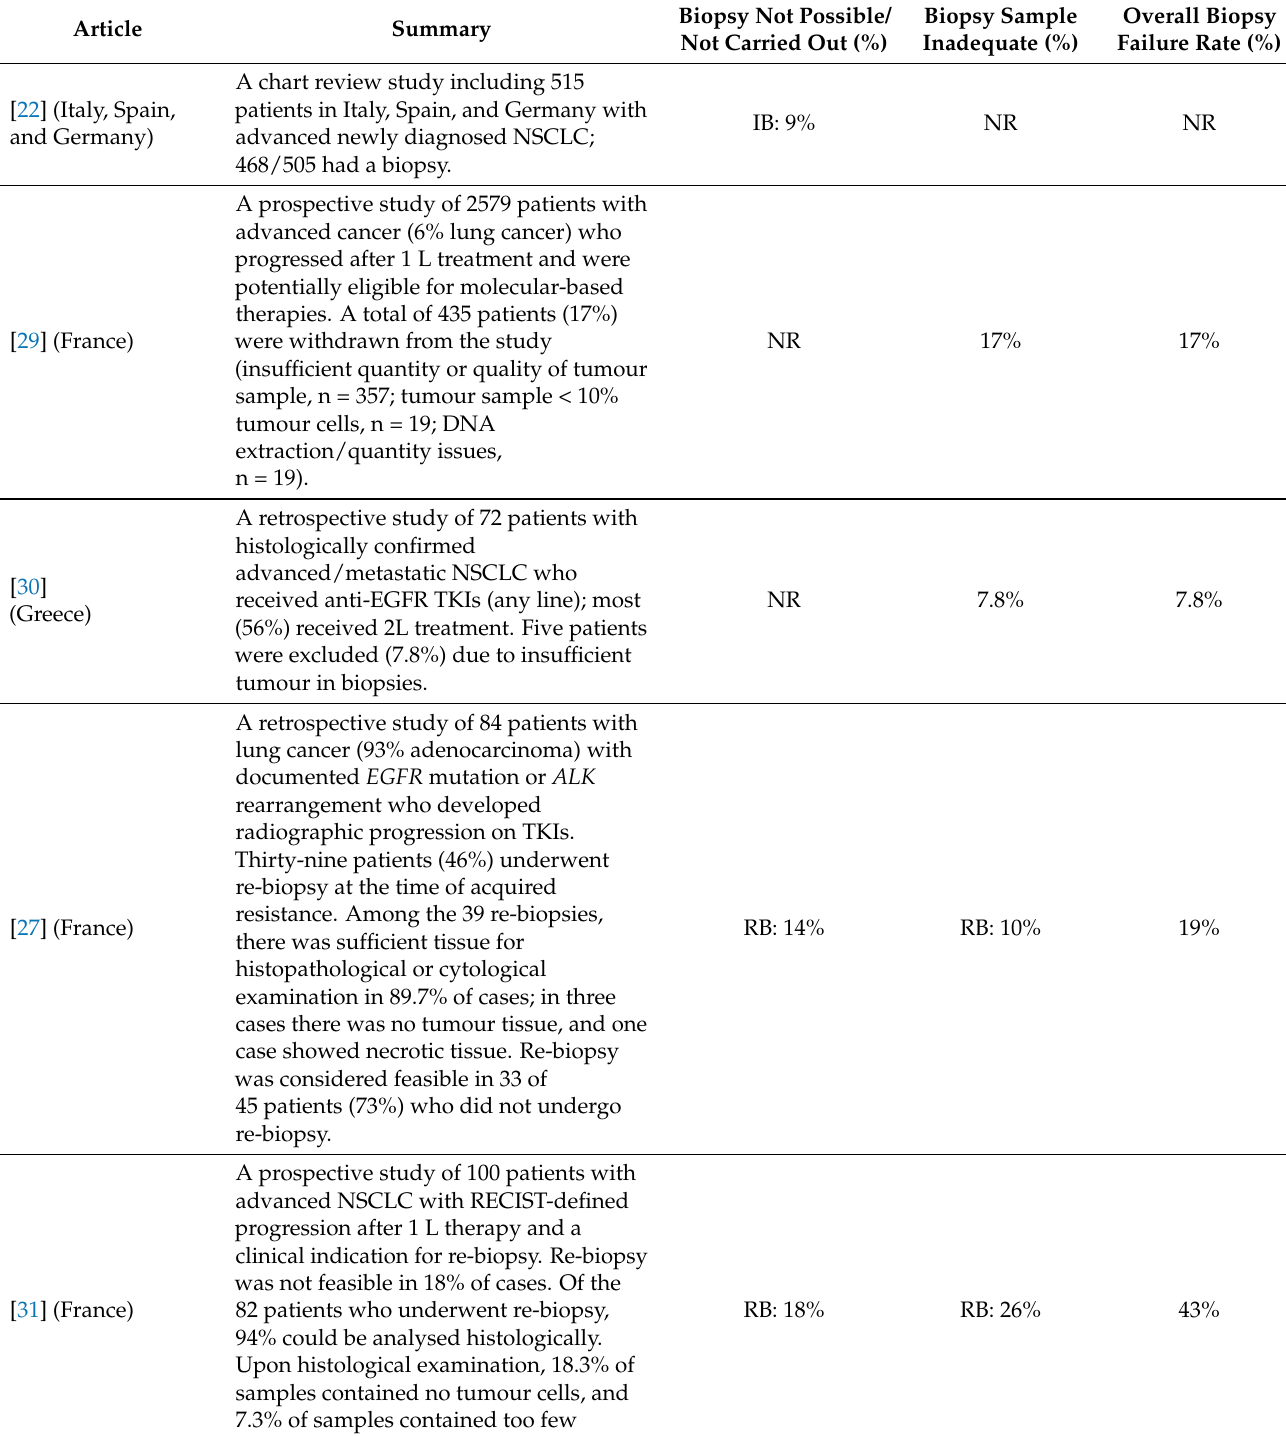
Table 2. Rates of inadequate tissue biopsy in patients with advanced NSCLC (European